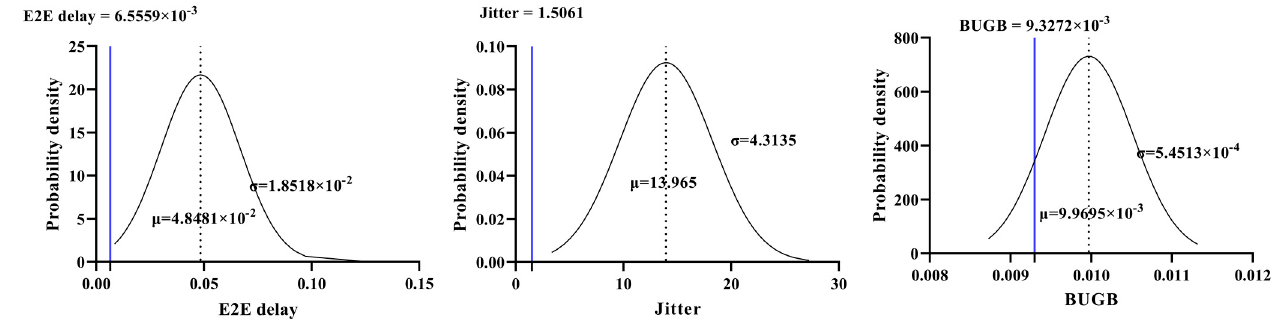
Figure 10. Best performance metrics compared with random schedules.